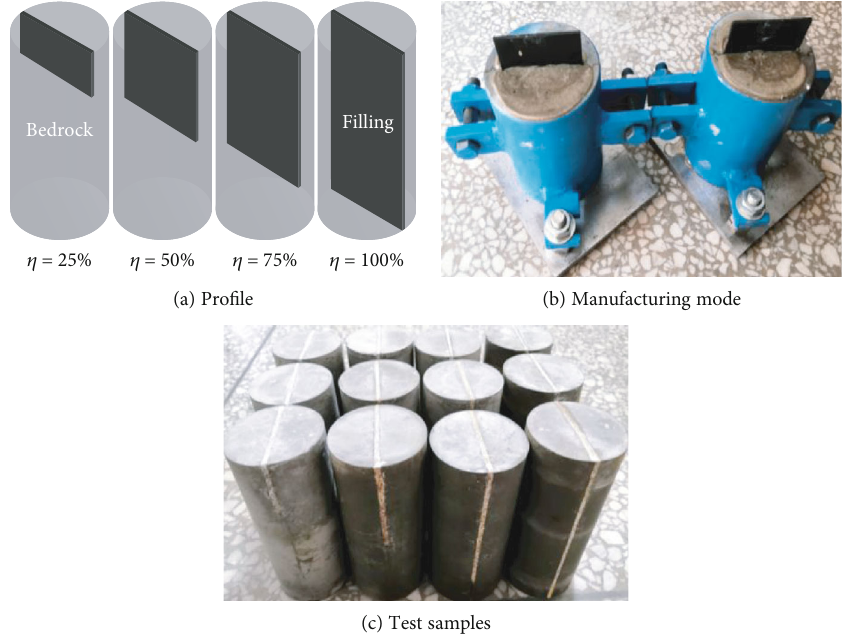
Figure 1: Sample production.